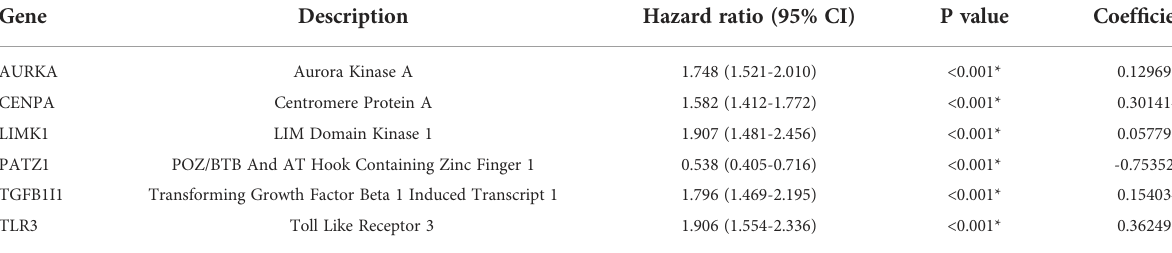
TABLE 1 Senescence-related genes, the relationship with OS, and the coef fi cients in LASSO regression model.